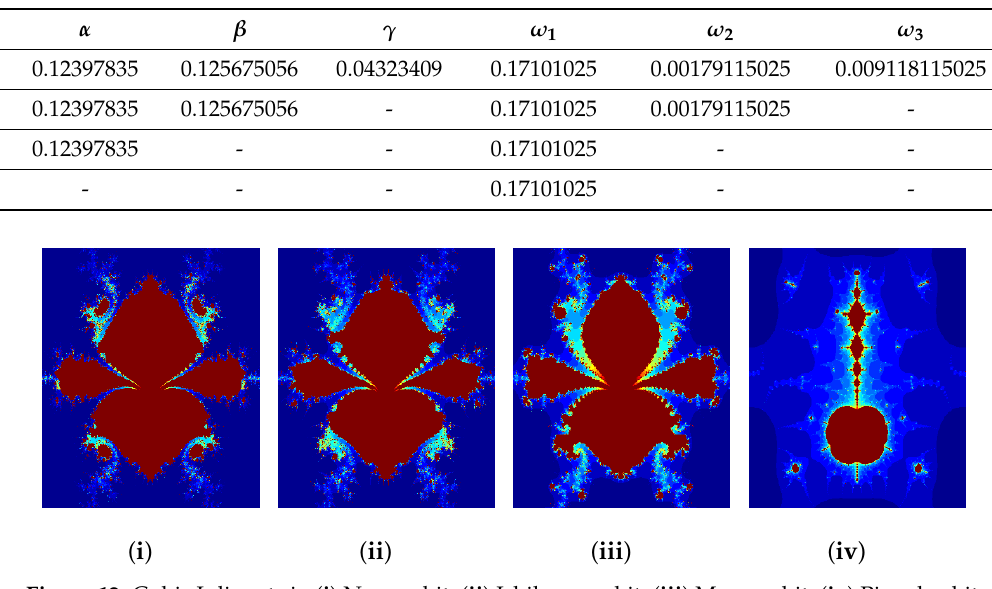
Figure 12. Cubic Julia sets in ( i ) Noor-orbit; ( ii ) Ishikawa-orbit; ( iii ) Mann-orbit; ( iv ) Picard-orbit.